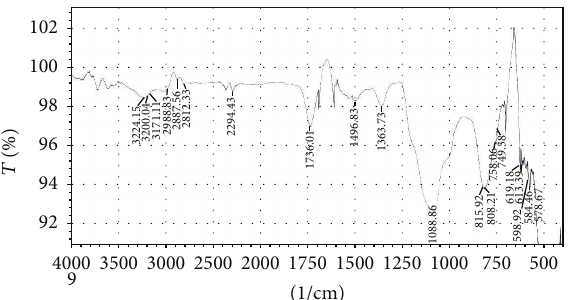
Figure 14: FTIR spectrum of corrosion product from mild steel surface after immersion in 1N H 2 SO 4 containing t (3)-methyl- r (2), c (6)-diphenylpiperidin-4-one (02).